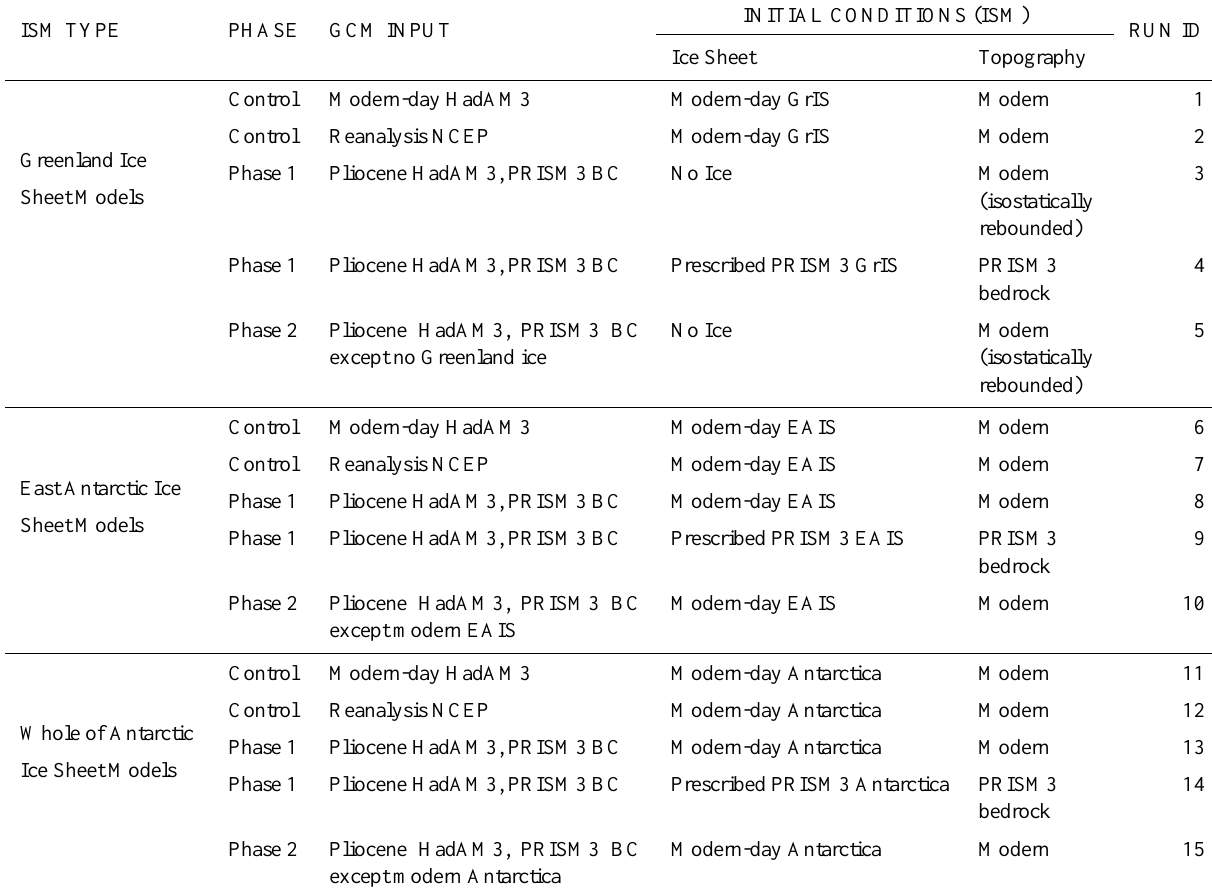
Table 1. Experimental design. Models are run over the three domains of Greenland, East Antarctica, and the whole of Antarctica (including the West Antarctic Ice Sheet). The control phase corresponds to simulations of present-day/pre-industrial conditions and Phases 1 and 2 apply to Pliocene climates. Phase 1 comprises experiments where the initial conditions in the ISMs are altered, whereas Phase 2 experiments focus on changing the boundary condition prescribed in the climate model. Forcing fields for the ISMs are derived from modelled (HadAM3) and reanalysis data sets (NCEP2). Initial conditions refer to the ice sheet configurations and the topographic state used to initiate the ice sheet modelling